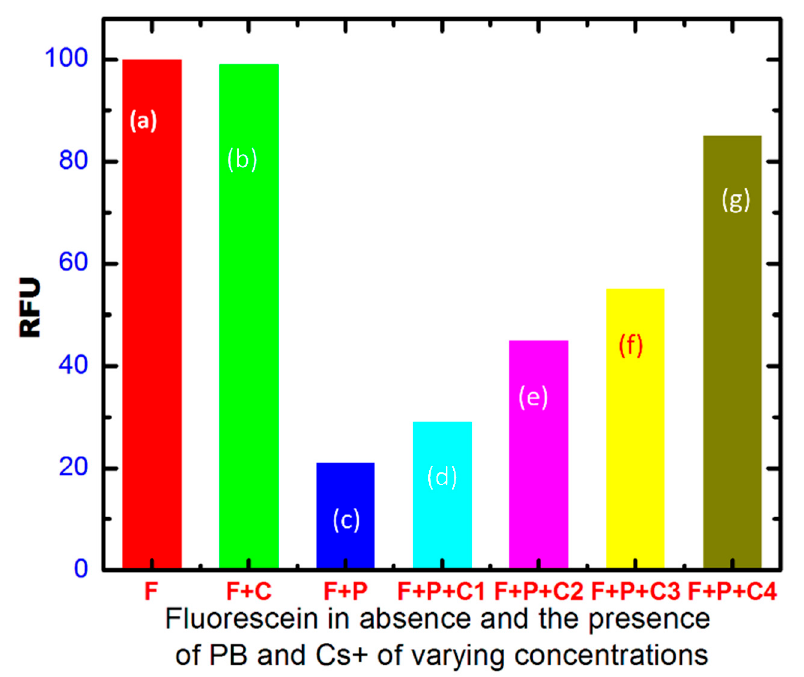
Figure 10. Fluorescence emission spectra of fluorescein. (a) Fluorescein and 200 ppm Cs + ; (b) Fluorescein and PB nanoparticles; (c) Fluorescein containing PB and 50 ppm Cs + ; (d) Fluorescein containing PB and 100 ppm Cs + ; (e) Fluorescein containing PB and 300 ppm Cs + ; (f) Fluorescein containing PB and 500 ppm Cs + ; (g) Fluorescein containing PB and 1000 ppm Cs + .